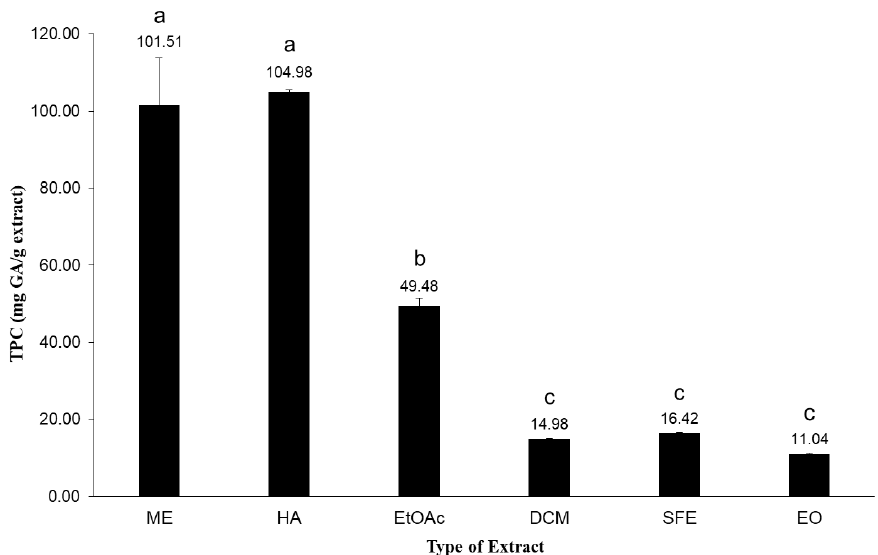
Figure 3. Total Phenolic Content (TPC) of the crude methanol (ME), water / methanol (HA), ethyl acetate (EtOAc), dichloromethane (DCM) and supercritical fluid (SFE) extracts, along with the essential oil (EO) obtained from S. sipylea . The values are the mean of three replicate determinations ± standard deviation. Di ff erent letters indicate significant di ff erences among TPC values ( p < 0.05).